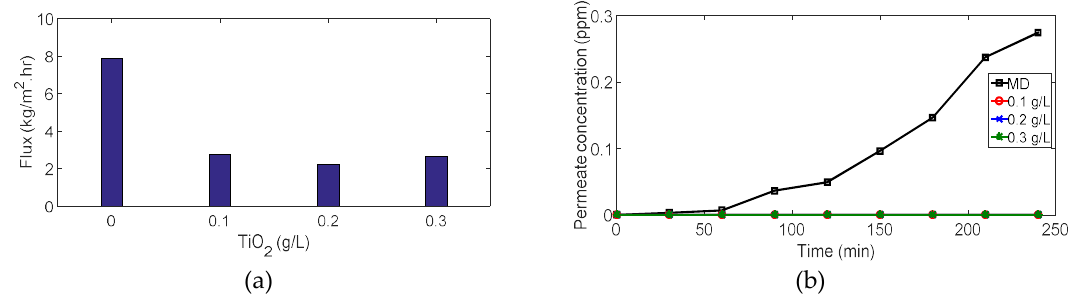
Figure 10. Results for 4 ppm methylene blue (MB) experiments: ( a ) flux vs. amount of TiO (cid:2870) ; ( b ) Figure10. Resultsfor4 ppmmethyleneblue(MB)experiments: ( a )fluxvs. amountofTiO 2 ;( b )permeate permeate concentration vs. time. concentration vs.